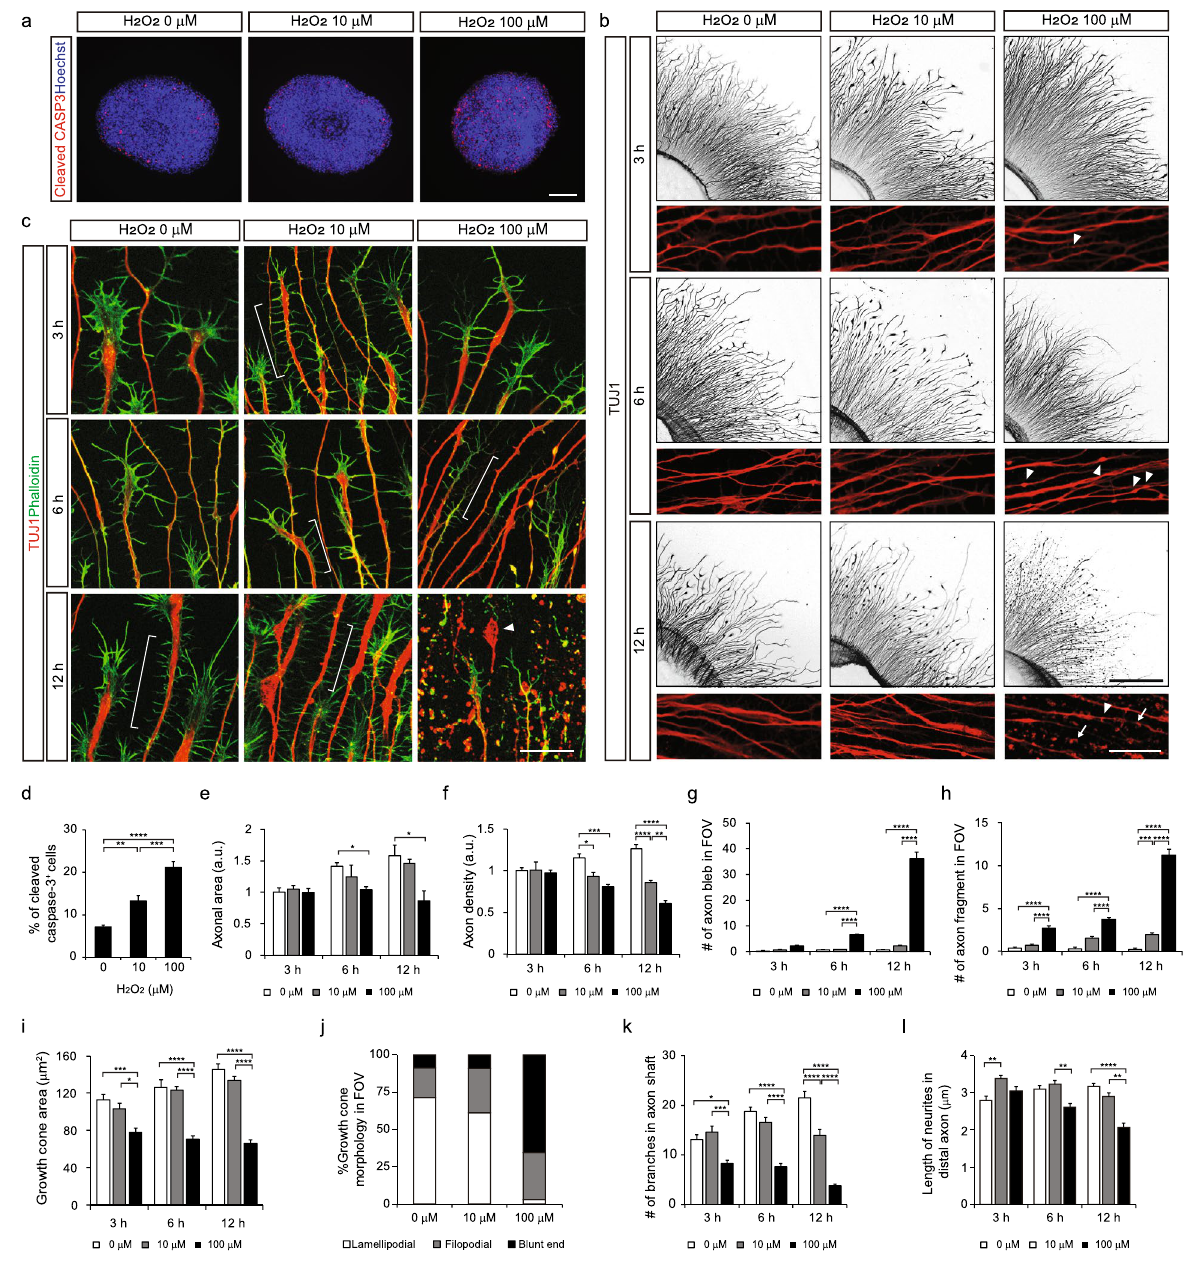
Figure 3. Oxidative stress–induced axon degeneration in motor nerve organoids. ( a ) Representative immunofluorescence images and quantification of organoids treated with H 2 O 2 for 6 h, stained with apoptosis marker cleaved-CASP3 antibody and Hoechst. Scale bar 100 μm. ( b ) Motor nerve organoids exposed to 10 and 100 μM of H 2 O 2 for 3, 6, and 12 h, and immunostained with TUJ1 antibody. Arrowheads indicate axon blebs and arrows indicate severed axon fragments. Scale bars 250 μm (upper panels) and 50 μm (lower panels). ( c ) Representative images of growth cones under the oxidative stress in motor axon model, immunostained with TUJ1 antibody and phalloidin. Note that retraction bulb-like deteriorating axon structure (arrowhead) and dramatic reduction of neurites along the axon shaft (compare brackets) in 100 μM of H 2 O 2 –treated group. Scale bar 50 μm. ( d ) Quantification of the percentage of cleaved CASP3 + cells among the total number of cells stained with Hoechst dye (n = 9–27 images per condition). ( e – h ) Quantification of axonal area per organoid ( e ) (n = 3–16 organoids per condition), axon density per field ( f ) (n = 29–61 images per condition), the number of axon blebs ( g ) (n = 24–36 images per condition), and the number of fragments per field ( h ) (n = 19–33 images per condition). ( i ) Measurement of growth cone area at various time points. (n > 120 growth cones per condition). ( j ) The growth cones at 6 hours were categorized into three types: lamellipodial, filopodial, and blunt growth cones. (n = 91–120 growth cones per group). ( k , l ) The number and average length of neurites in axon shafts (< 100 μm from the axon tip) were reduced by H 2 O 2 treatment (n = 12 axons per condition in k , and n = 44–257 neurites per condition in l ). Error bars represent s.e.m.; *p < 0.05, **p < 0.01, ***p < 0.001, ****p < 0.0001; one-way ANOVA test with Tukey’s